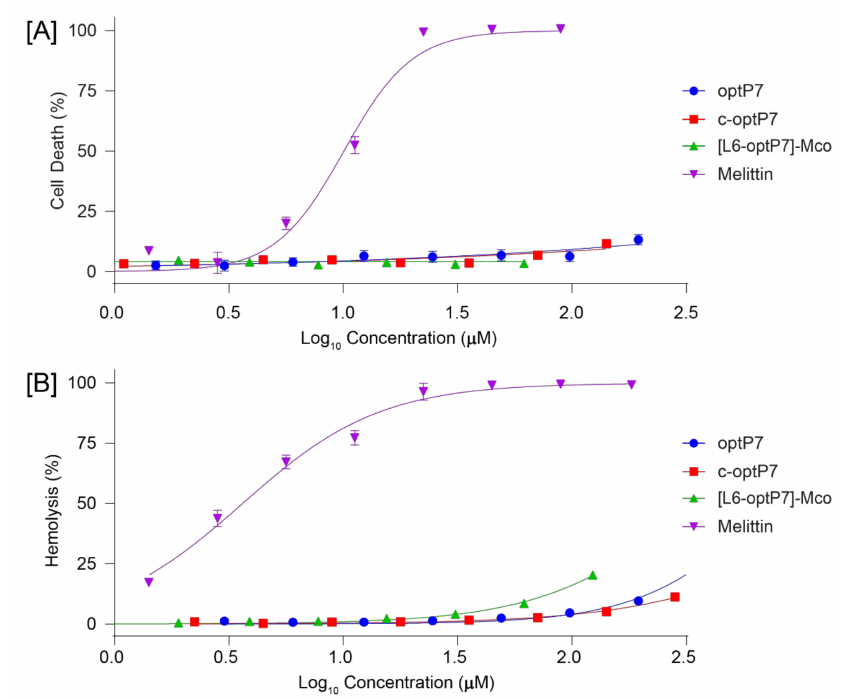
Figure 7. Cytotoxic ( A ) and hemolytic ( B ) activity measured against HEK-293 and human red blood cells in a dose-dependent